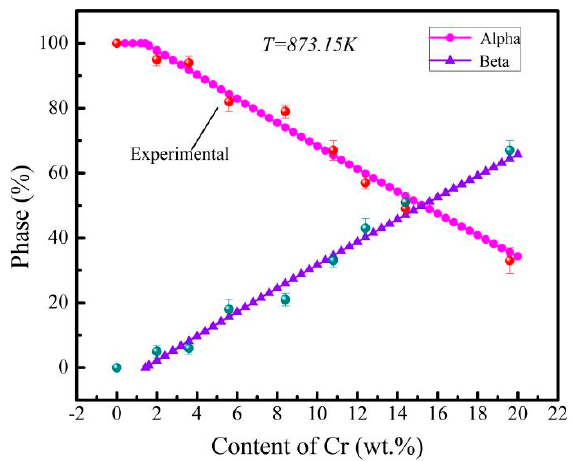
Figure 5. The calculation results of the phase composition of Ti ‐ 6Al ‐ xCr alloys, after aging at 600